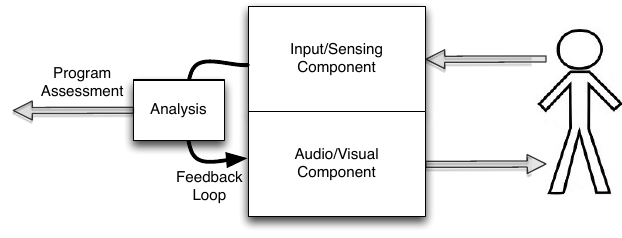
Figure 1. A system model for technology-facilitated systems used for autism